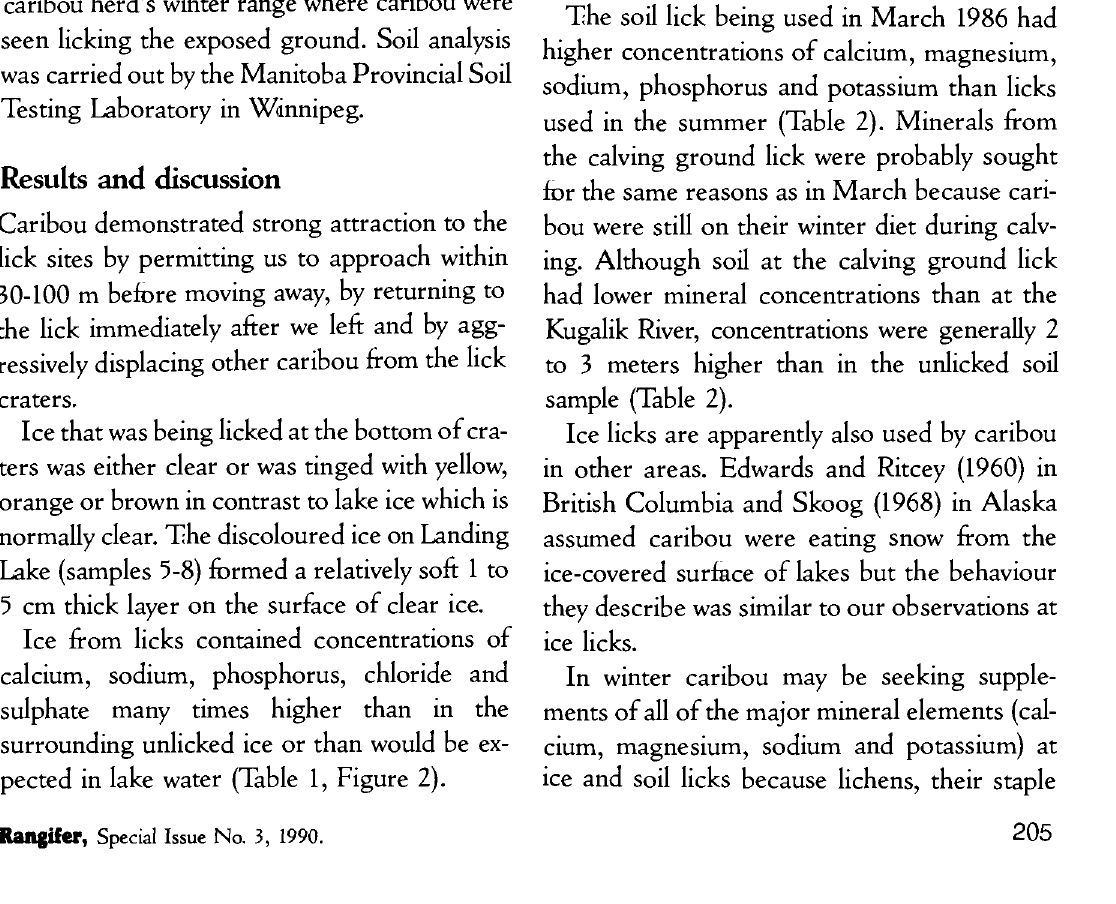
Figure 2. A comparision of the mineral compositi on of unlicked ice with ice at ice